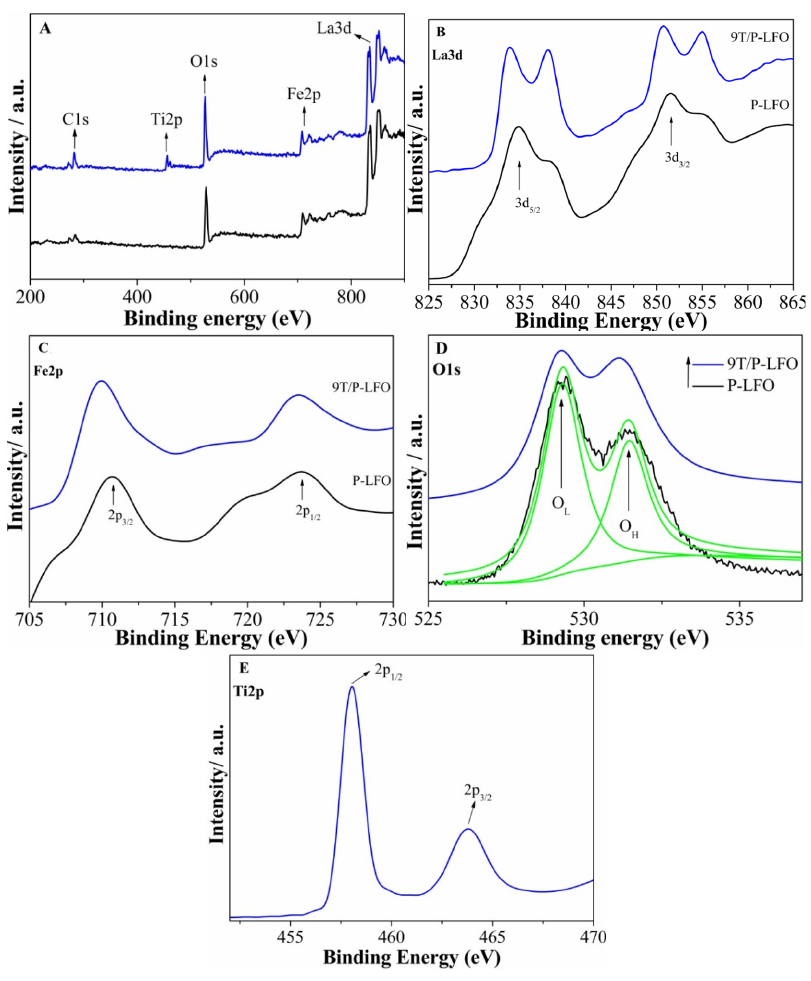
Figure 3. X-ray photoelectron spectroscopy (XPS) survey spectra of P-LFO and